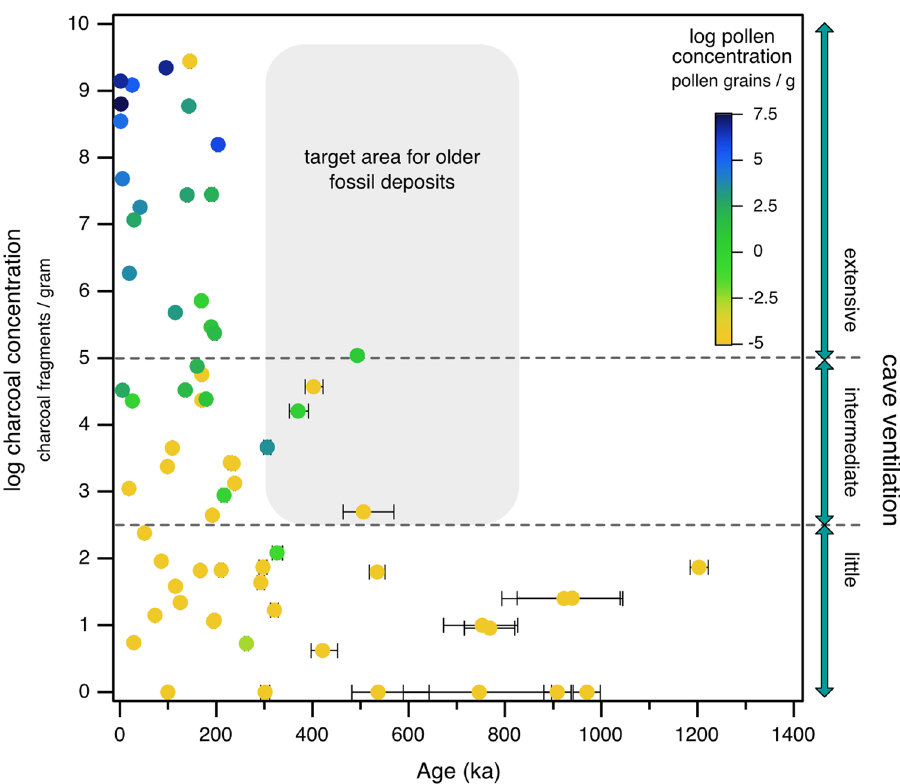
Fig. 4 Chronology of the Naracoorte Cave Complex in the context of proxies of cave ventilation dynamics. Charcoal and pollen concentrations within the speleothem samples by age, with 2 σ uncertainties (whiskers). Charcoal and pollen concentrations are presented on log scales (natural log values <2 indicate ≤ 7 pieces of microcharcoal or pollen per gram of calcite) because differences in their abundance between caves, and varying individual speleothem growth rates, are uncontrolled variables. See text for further discussion. Grey box indicates the suggested “ sweet spot ” : old speleothems with intermediate to high charcoal/pollen contents indicating early cave ventilation, which indicate caves that can serve as potential targets for future studies looking for older vertebrate fossil